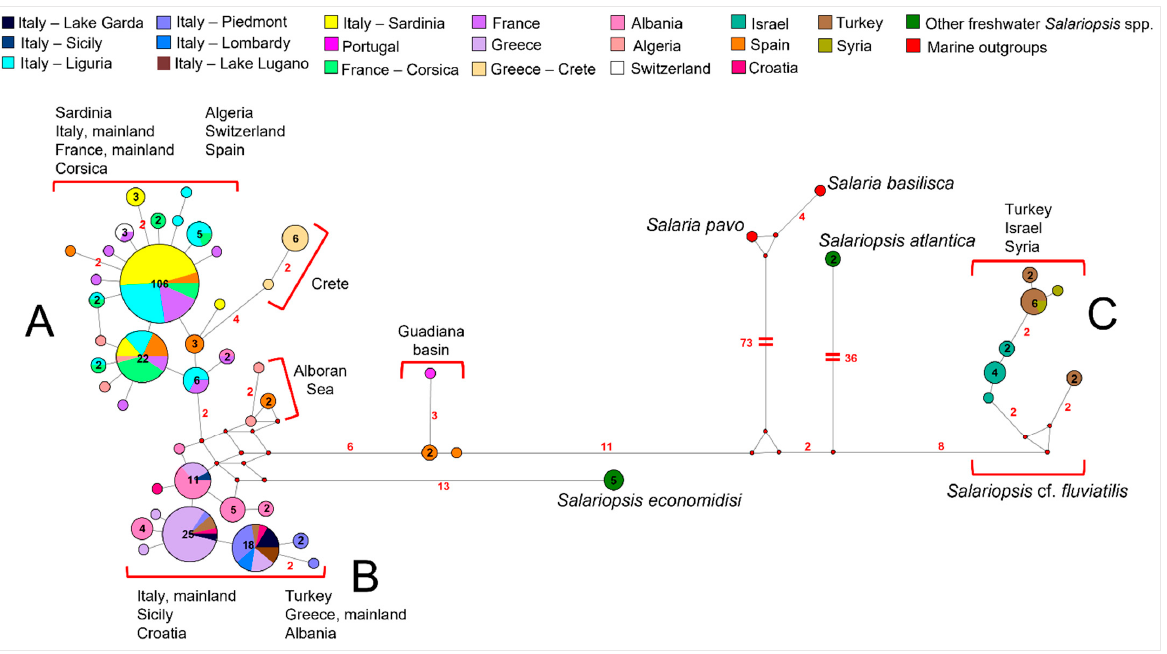
Figure 4. Median-joining network analysis performed on the whole Control Region dataset. Clusters A, B and C are described in the text. The number of mutations between sequences that are greater than n = 1 are reported on network branches. Additionally, the number of individuals showing the same haplotype that is greater than n = 1 is reported inside the spot.